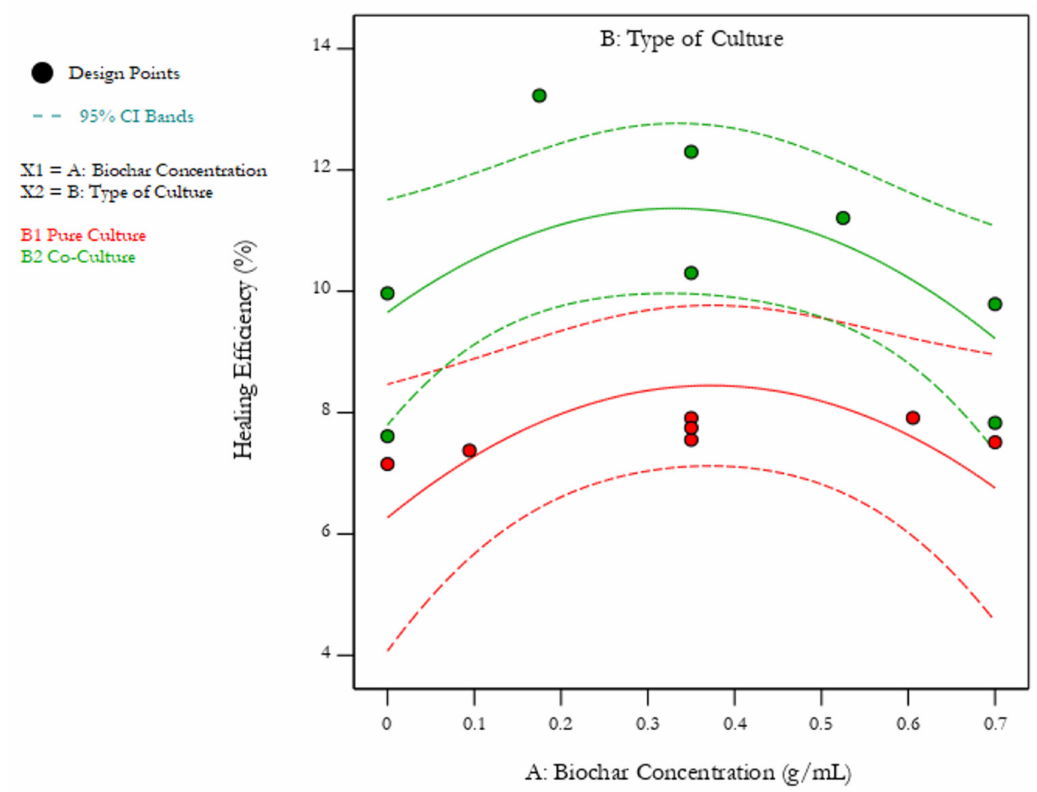
Figure 5. Graphical model on the e ff ects of biochar-immobilization and co-culturing.